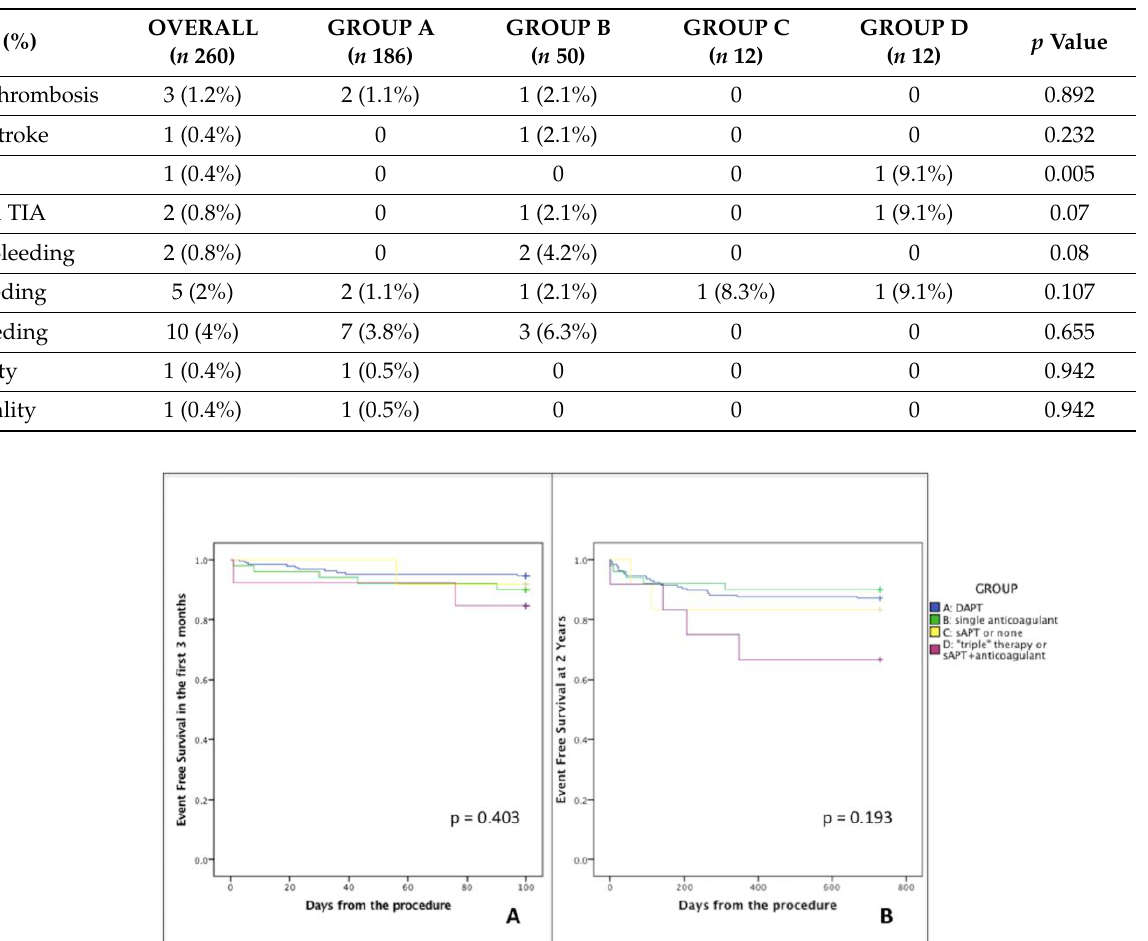
Table 3. Clinical follow up at three months. TIA: transient ischemic attack; CV: cardiovascular. GROUP A dual antiplatelet therapy; GROUP B anticoagulant therapy; GROUP C single antiplatelet therapy or no therapy; GROUP D combination of antiplatelet and anticoagulant therapy.